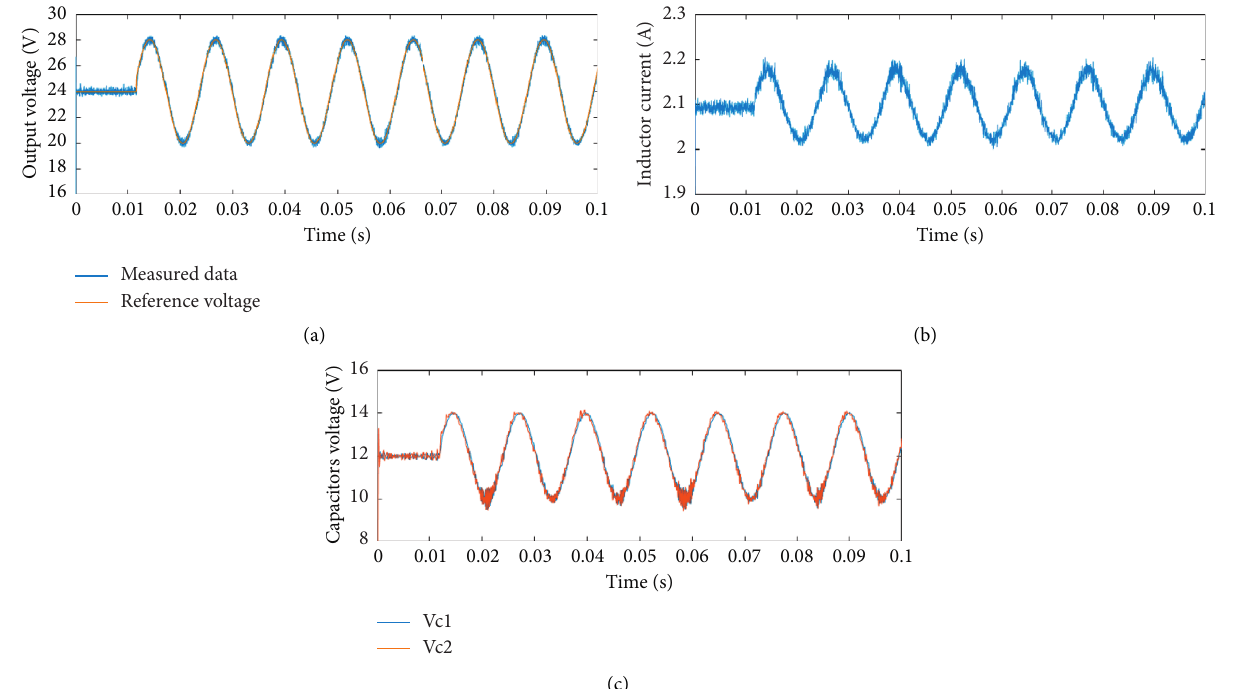
Figure 18: Experimental waveforms. (a) Output voltage. (b) Inductor current. (c) Vc 1 and Vc 2, resulted for a sinusoidal reference 24+4sin (2 π 100 t